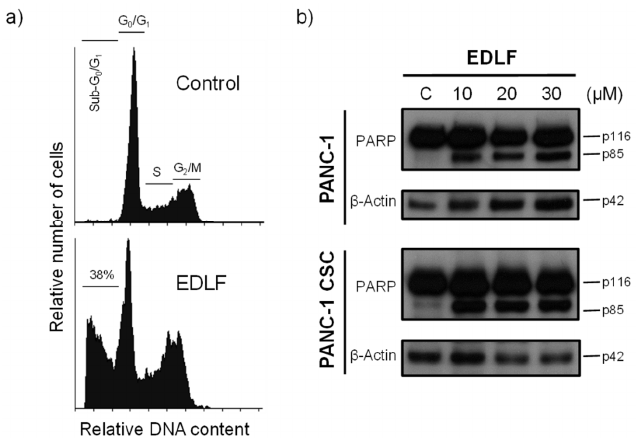
Figure 4. Induction of apoptosis in PANC-1 CSCs by edelfosine. ( a ) PANC-1 CSCs were incubated in the absence (control) or presence of 20 µ M edelfosine (EDLF) for 5 days, and then apoptosis was analyzed by means of flow cytometry. The different cell cycle stages are indicated. The percentage of apoptotic cells in the sub-G 0 /G 1 region is shown. The data are representative of at least three independent experiments. ( b ) PANC-1 cells and PANC-1 CSCs were untreated (C) or treated with edelfosine (EDLF) at the indicated concentrations for 48 h and analyzed by means of Western blotting using specific antibodies for PARP; β -actin was used as the loading control. Molecular weights (in kilodaltons) of every protein are indicated at the right side of each panel. The gels were cropped to show the relevant sections. The Western blot images are representative of three independent